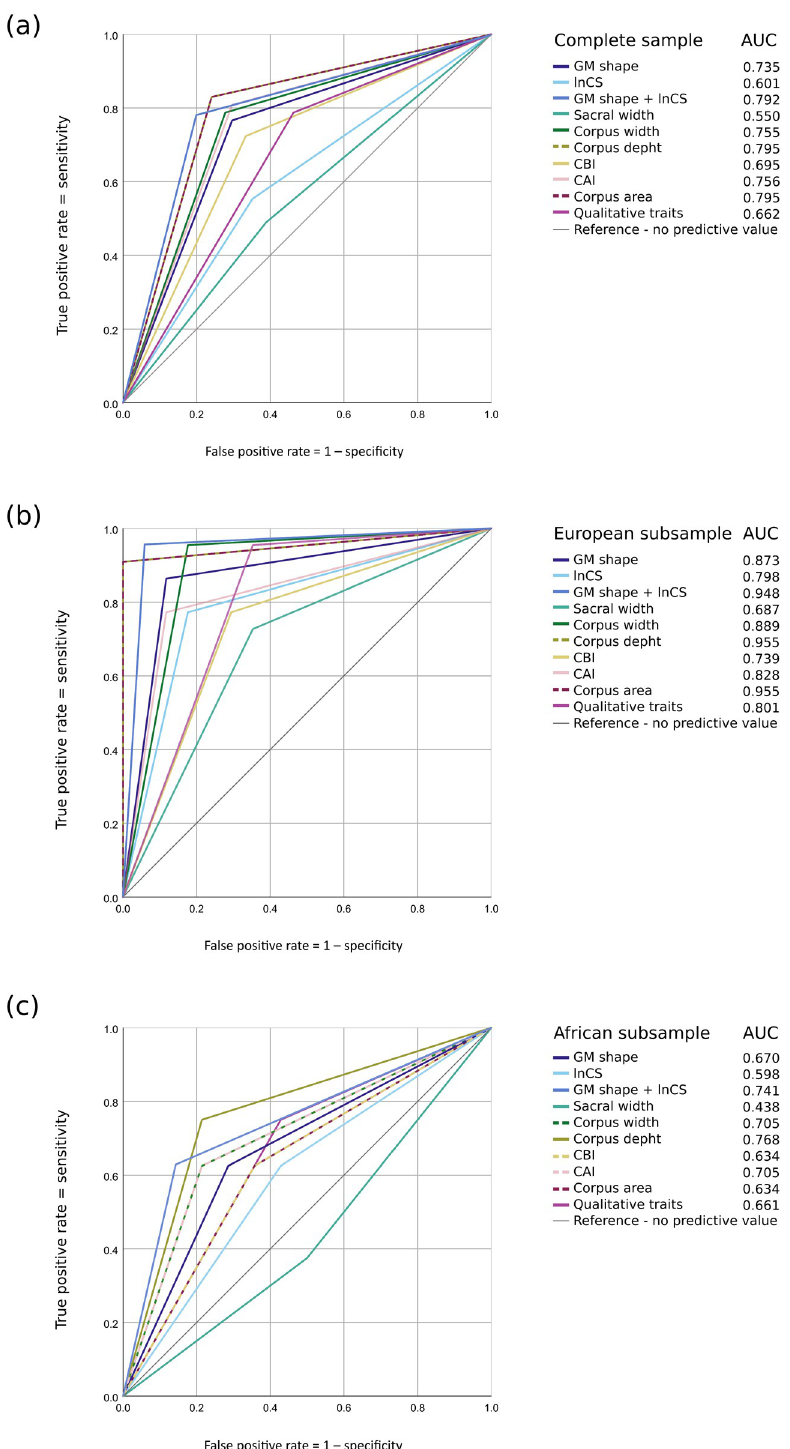
Fig 6. ROC curves based on predicted group membership from linear discriminant analyses for all classification methods reporting the area under the curves (AUCs). (a) ROC curves for the complete sample (n = 101), (b) the European subset (n = 39) and (c) the African subset (n = 22). Corpus depth was the single most discriminative measurement while sacrum width was the weakest for all samples. Note that dotted lines represent similar thresholds for two parameters (i.e., corpus depth/corpus area in a and b; corpus width/CAI and corpus area/CBI in c).